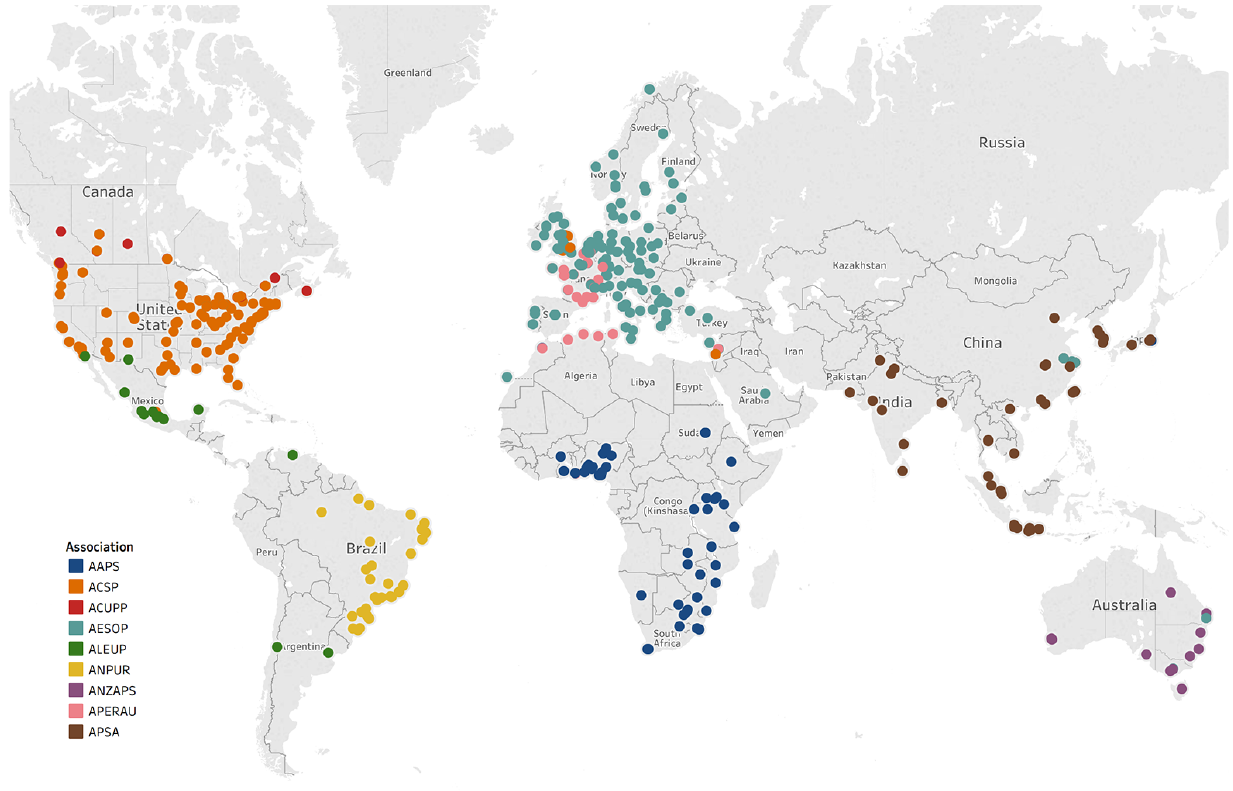
Figure 1. Location of the members of the GPEAN. Note that TUPOB and ASPI are not included in this map for reasons of legibility. Source: